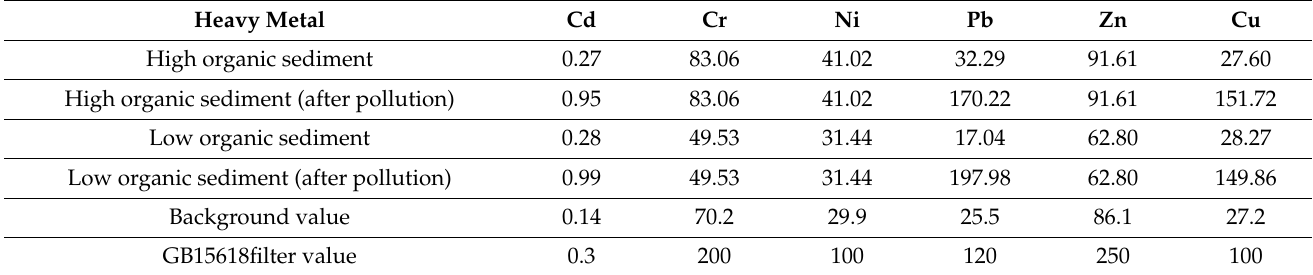
Table 2. Heavy Metal Content of Sediments before and after Contamination (mg · kg − 1